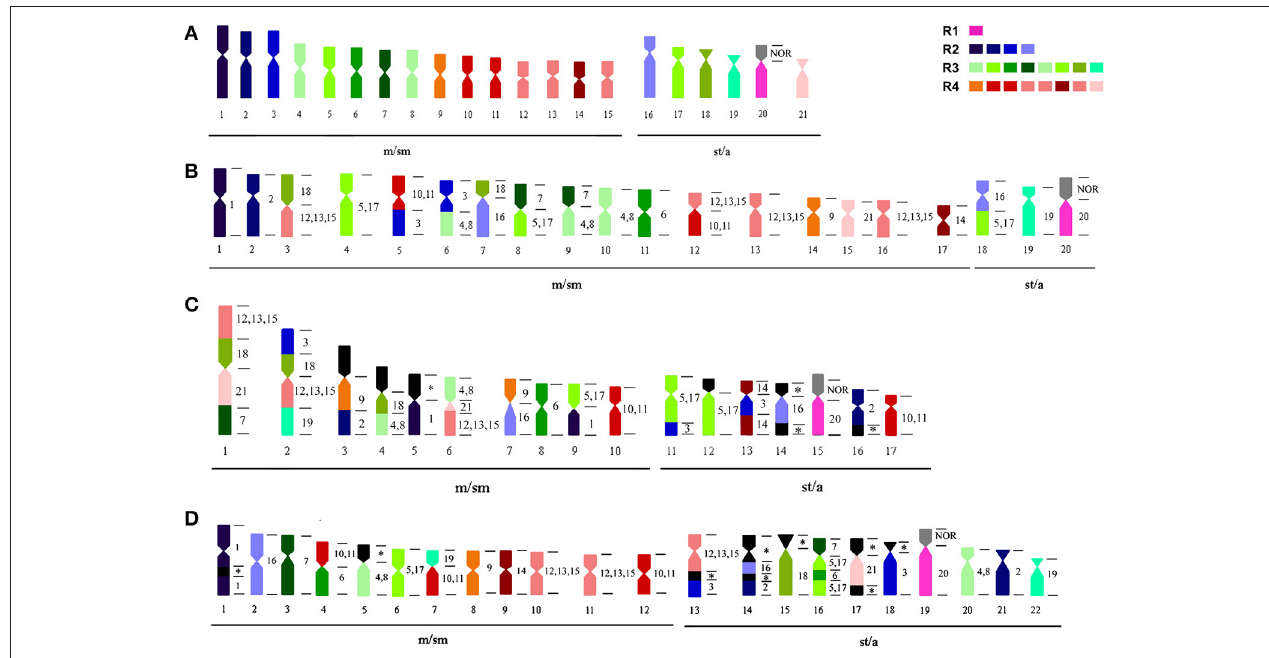
FIGURE 4 | Ideogram with the karyotypes of (A) G. carapo (2 n = 42); (B) G. carapo (2 n = 40); (C) G. capanema , and (D) G. arapaima. The numbers at the right side of chromosomes in (B–D) show the homology with the karyotype (A) of G. carapo. Each color in the karyotypes (B–D) represents the correspondent chromosome colored in (A) . Chromosomes groups [4, 8]; [5, 17]; [10, 11], and [12, 13, 15] share the same color within each group.